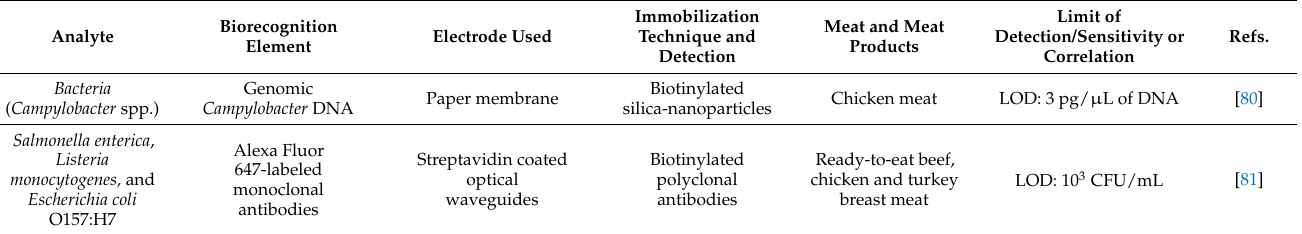
Table 3. Biosensors for the detection of various microbes and toxins in meat and meat